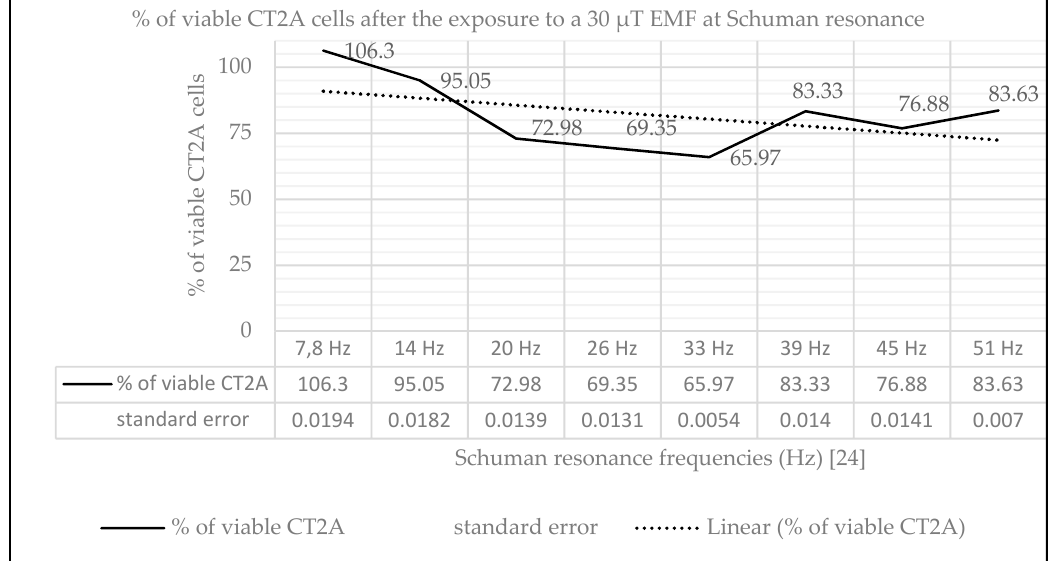
Figure 1. Graphical representation of % of viable CT2A cells after the exposure during 24 h to an EMF of 30 μ T at the different frequencies of the Schuman resonance [23]: 7.8, 14, 20, 26, 33, 39, 45, and 51 Hz.